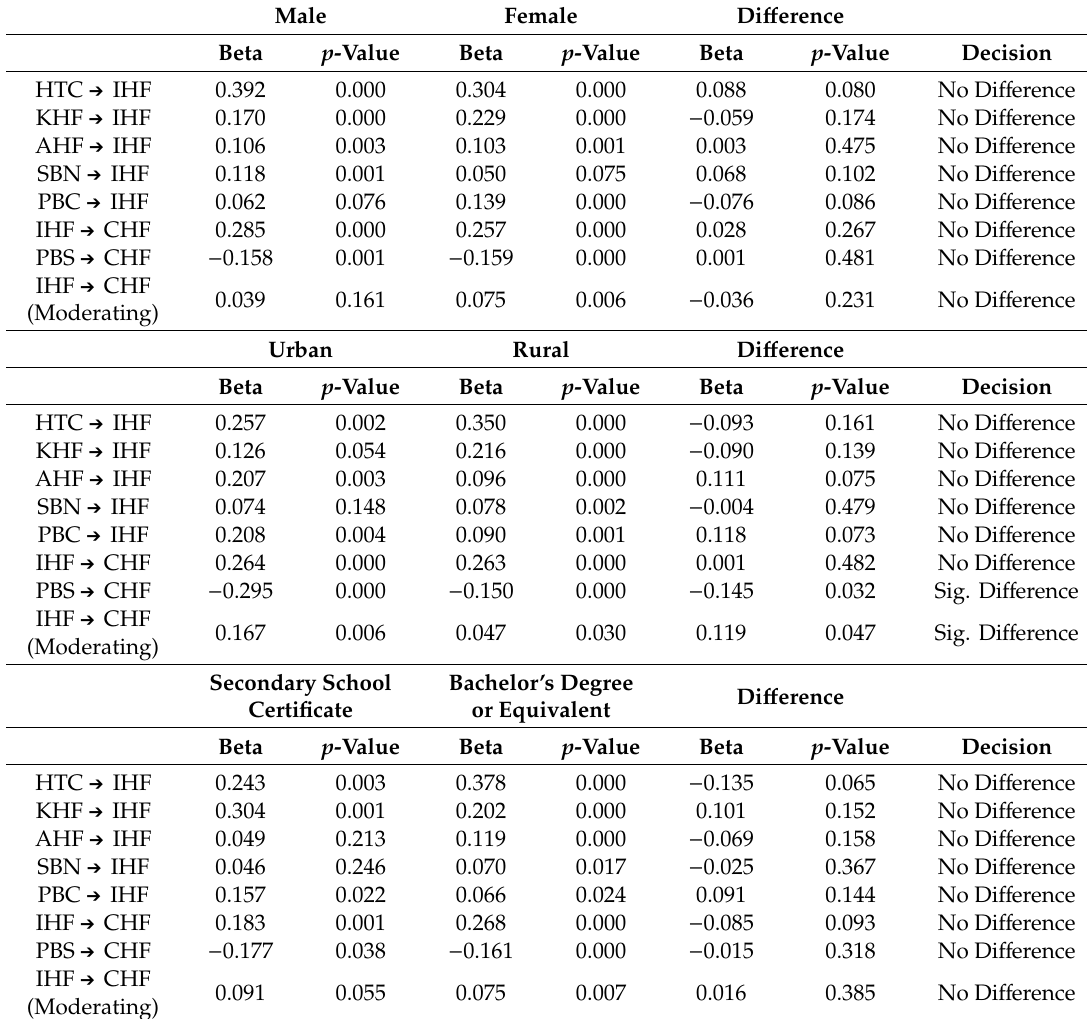
Table 7. Multi-group